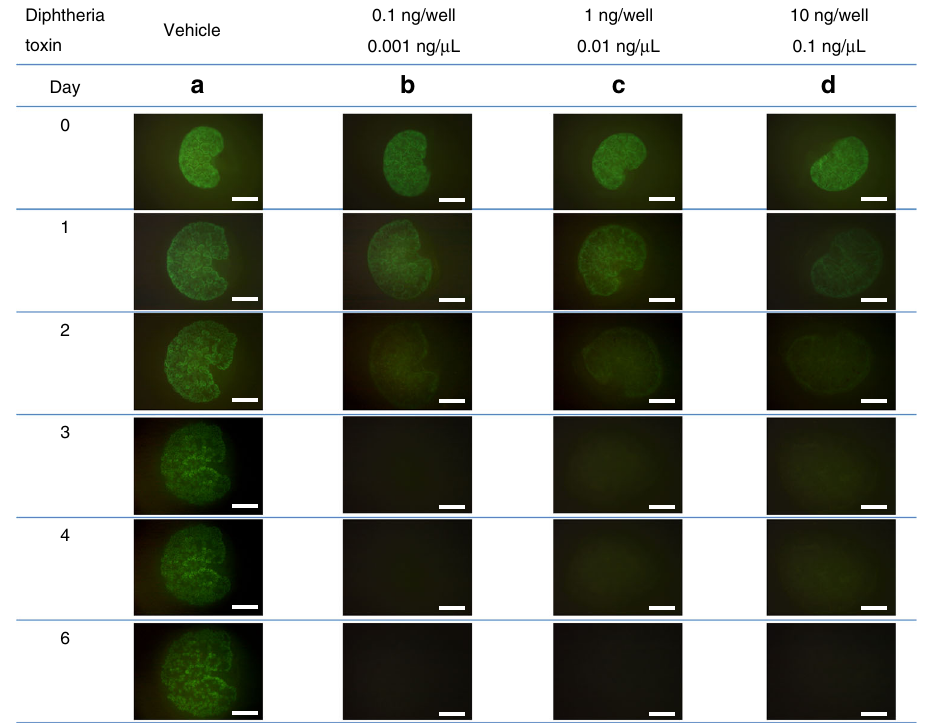
Fig. 4 Adjusting the concentration of diphtheria toxin (DT). a - d We evaluated cell elimination by administering a dose of diphtheria toxin (DT). Vehicle (phosphate-buffered saline (PBS))-treated Six2-iDTR mice served as controls. In the metanephros (MN) of Six2-iDTR mice, apoptotic death of Six2-GFP cells in the CM resulted from DT-mediated cell elimination at all densities (0.5 ng/well (medium, 400 µ L) to 50 ng/well; scale bar, 500 µ